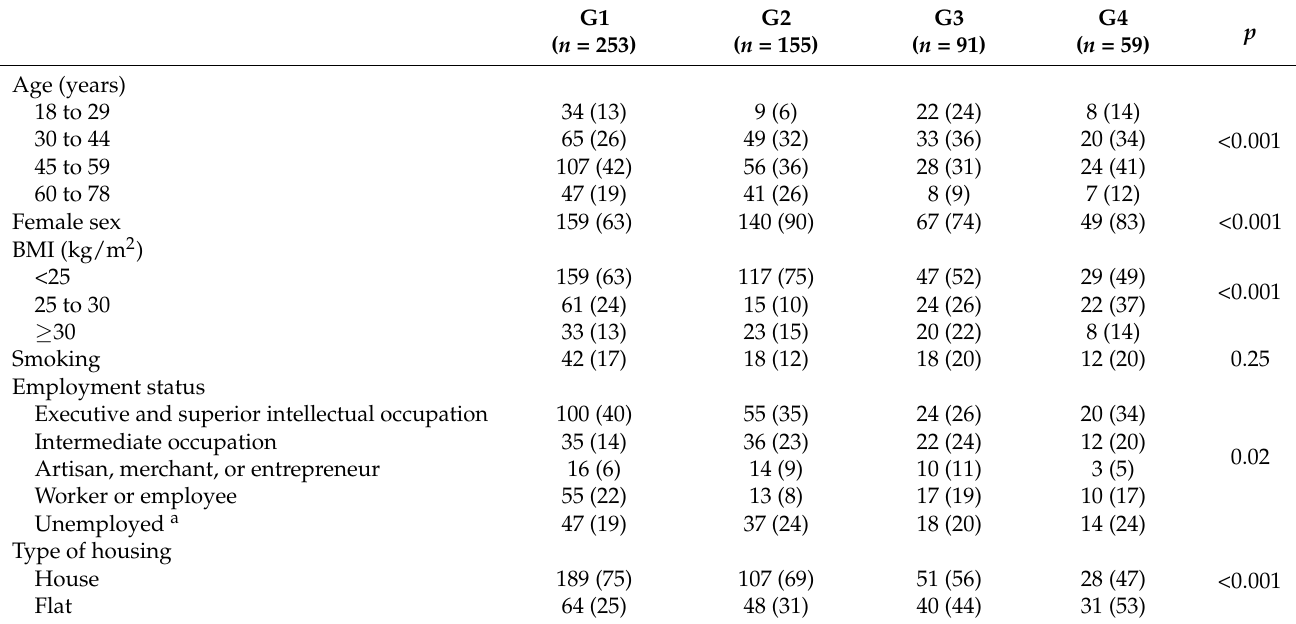
Table 3. Characteristics of participants in each group obtained after multiple-correspondence